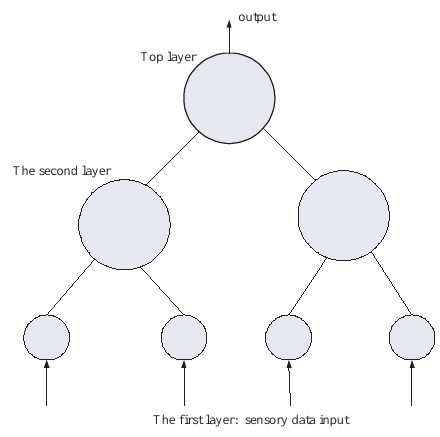
Figure 3. A simple HTM network